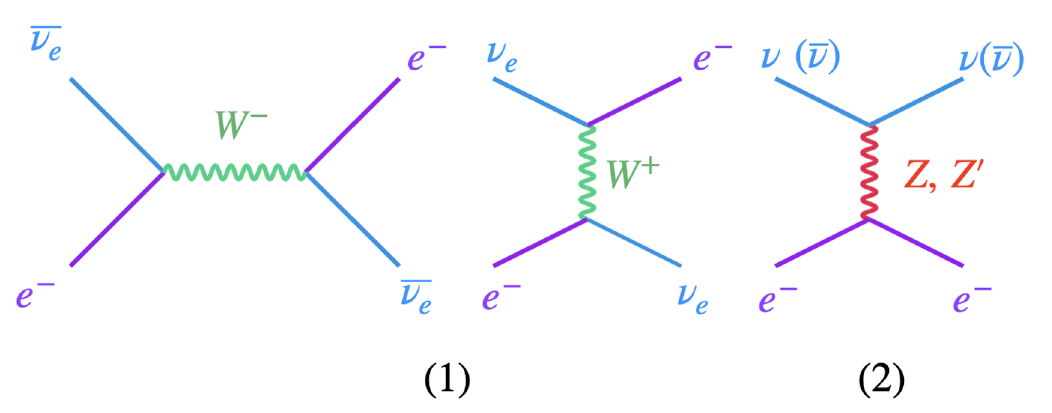
Figure 1 . The electron-neutrino scattering by the charged (1) and neutral (2) mediators in a general U (1) X scenario. The Z 0 vertices manifest the U (1) X